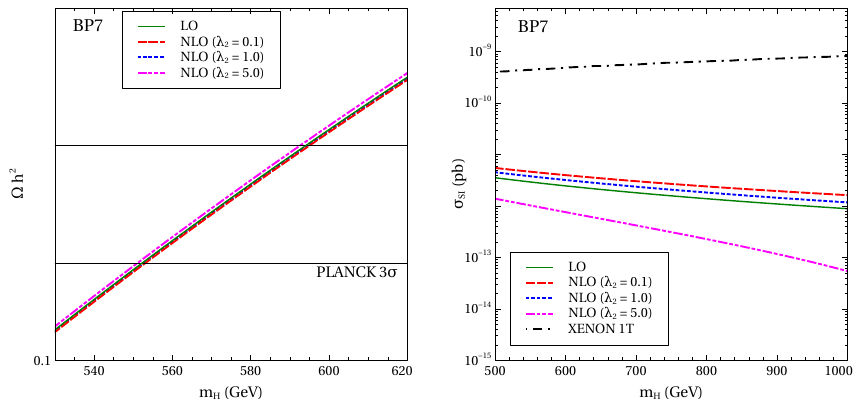
Figure 9 . Variation of the relic density (left) and the spin-independent cross section (right) with the DM mass. The tree level and one-loop values are denoted by the blue and red curves respectively. HZA , HW (cid:7) H (cid:6) and H (cid:6) H (cid:7) Z=(cid:13) vertices shall also receive potentially large